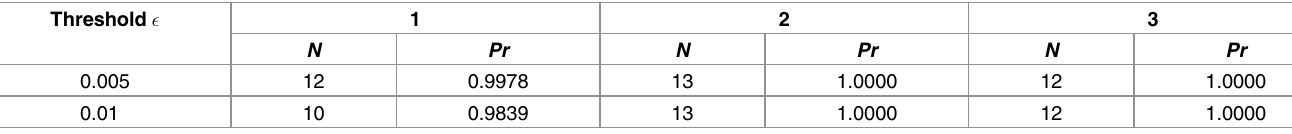
Table 7. M = 7, S = 6, distribution ~ p ð i Þ : Concentration